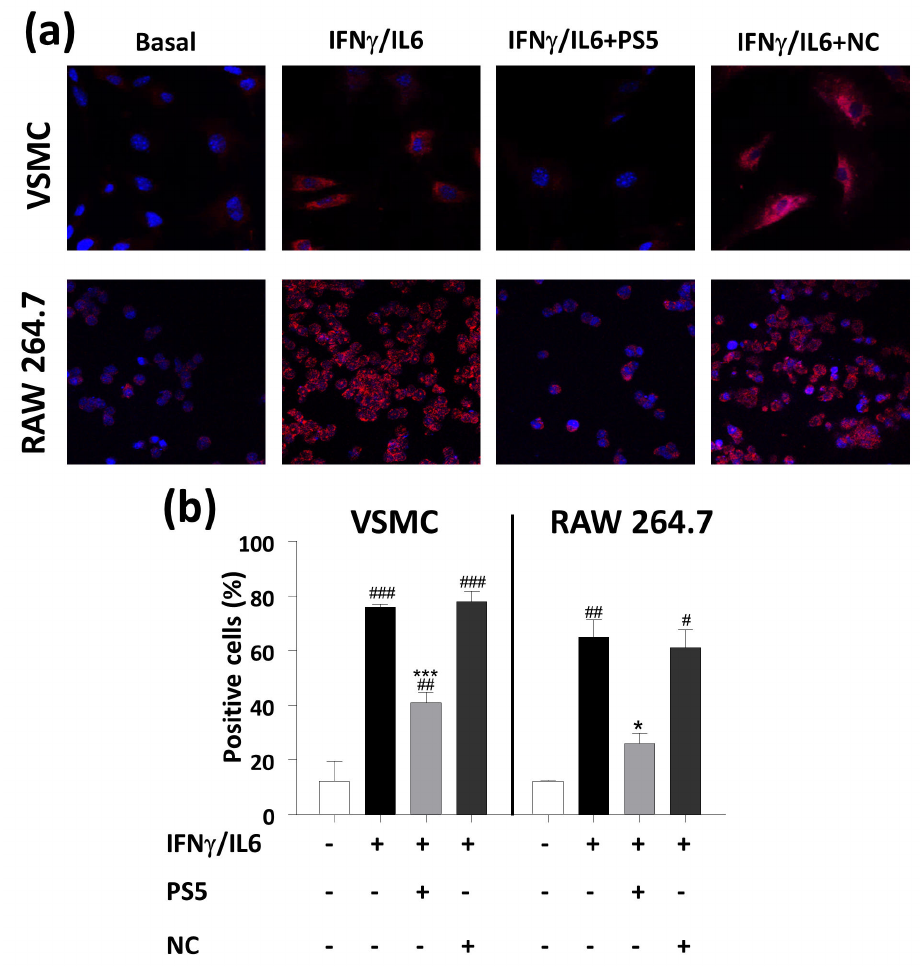
Figure 2. PS5 e ff ects on ROS production. ( a ) Representative confocal images of intracellular O 2 •− (red, DHE staining; blue, DAPI nuclear staining) in VSMCs and RAW 264.7 cells stimulated with cytokines in the presence or absence of PS5 and NC peptides. ( b ) Quantification of PS5 activity based on DHE fluorescence intensity. Results are presented as the mean ± SEM of n = 3 independent